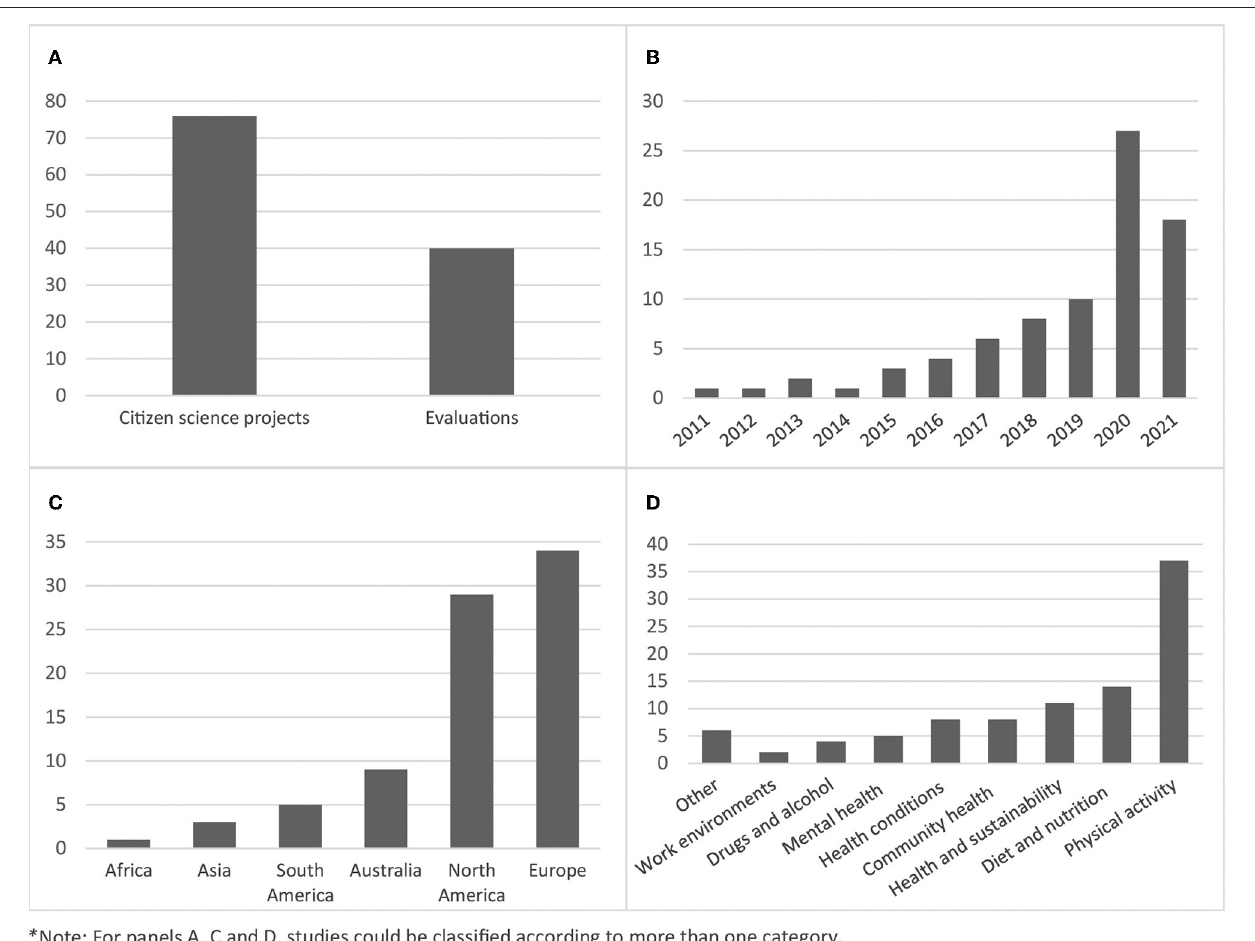
FIGURE 4 | Key characteristics of included articles ( N = 81). From top left to bottom right: (A) Number of articles that reported on citizen science projects or evaluations of citizen science projects; (B) Frequency of articles over time from 2011 to 2021; (C) Number of studies conducted in each continent; (D) Health topic area: number of studies targeting each health